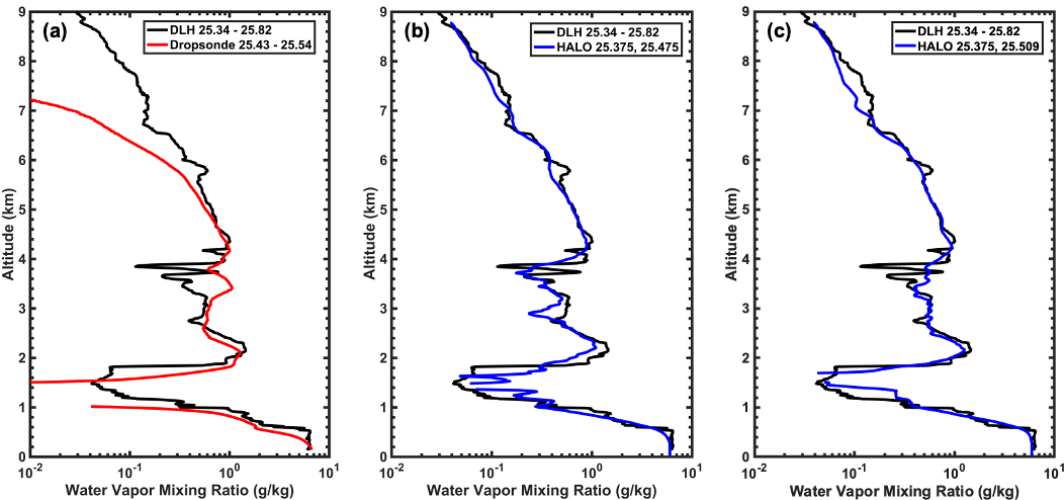
Figure 14. HALO and dropsonde comparisons with DLH. (a) Yankee XDD dropsonde (red) comparison against DLH-derived WVMR profile (black) from the descending DC-8 spiral. The time of flight for the sonde and those also used to generate the DLH profile are indicated in the legend. (b) HALO 315m vertical and 12km horizontal resolution WV profile (blue) comparison against DLH. There are two HALO profiles spliced together using the times indicated in the legend to account for the heterogeneity in the WV field over the spiral location and to account for the spatial offset between the HALO and DLH in situ spiral. Panel (c) is the same as panel (b) but with a different profile chosen for the lower tropospheric splice region. Data are shown on a logarithmic scale to highlight the large dynamic range throughout the depth of the